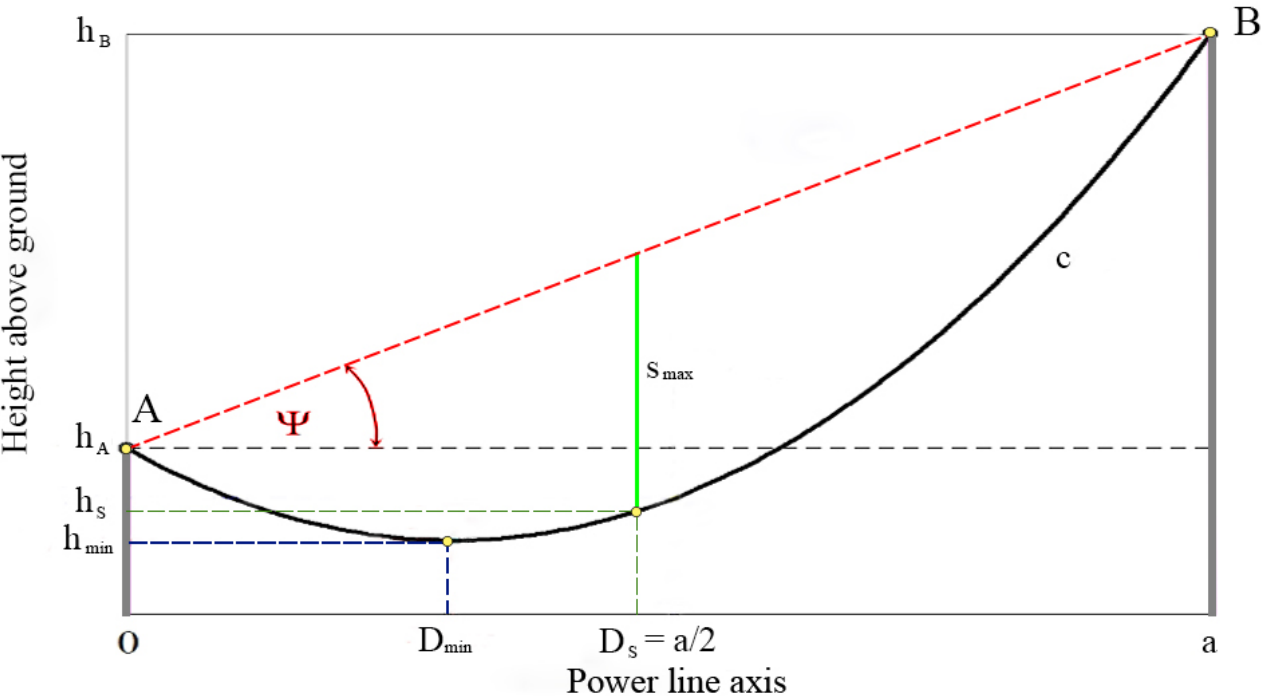
Figure 5. Catenary estimation based on the maximum sag hypothesis with the anchor points at different levels. A and B correspond to the anchor points of the wire to the insulators; Ψ is the angle of inclination between the two points; c is the wire catenary; s max corresponds to the maximum sag; h min is the minimum height of the wires above the ground according to the design standards.